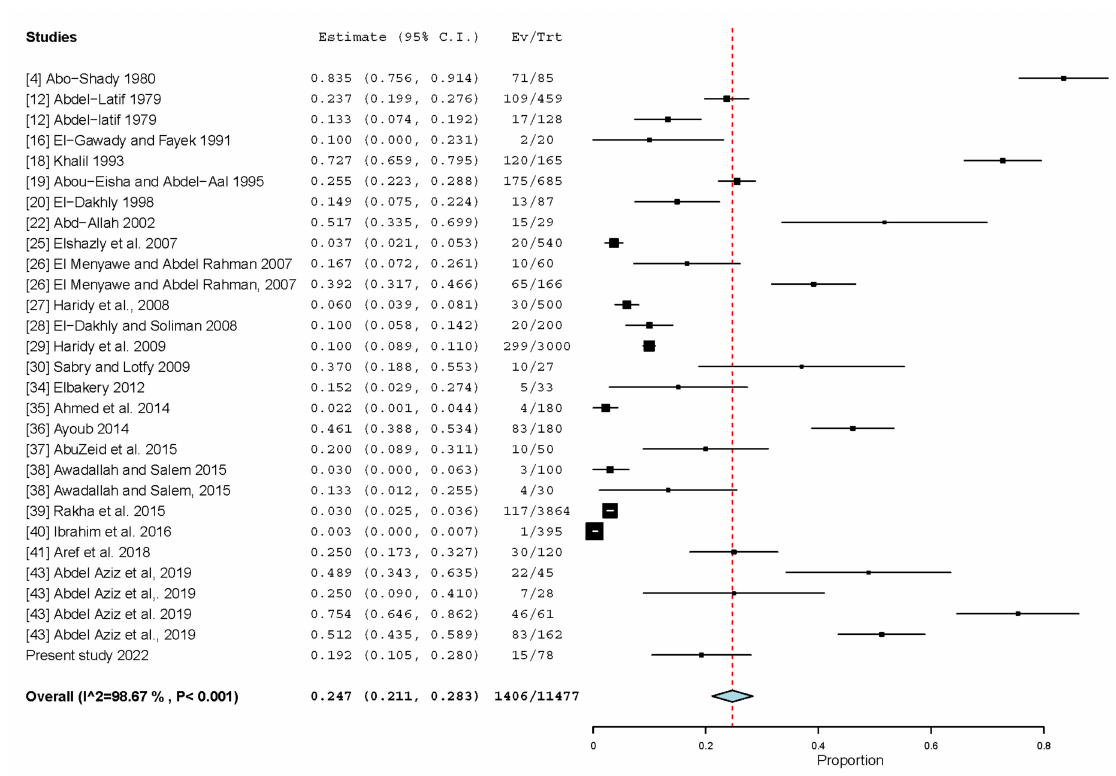
Figure 2. Forest plot diagram for random effects in the meta-analysis of the prevalence of T. canis in dogs from Egypt. The length of the line indicates 95% confidence interval of each study and the middle point of each line refers to the prevalence. Diamond refers to the overall prevalence. Table 4. Overall and regional pooled prevalence of Toxascaris leonina in dogs from various Egyptian regions, and variabilities according to dog life style and detection